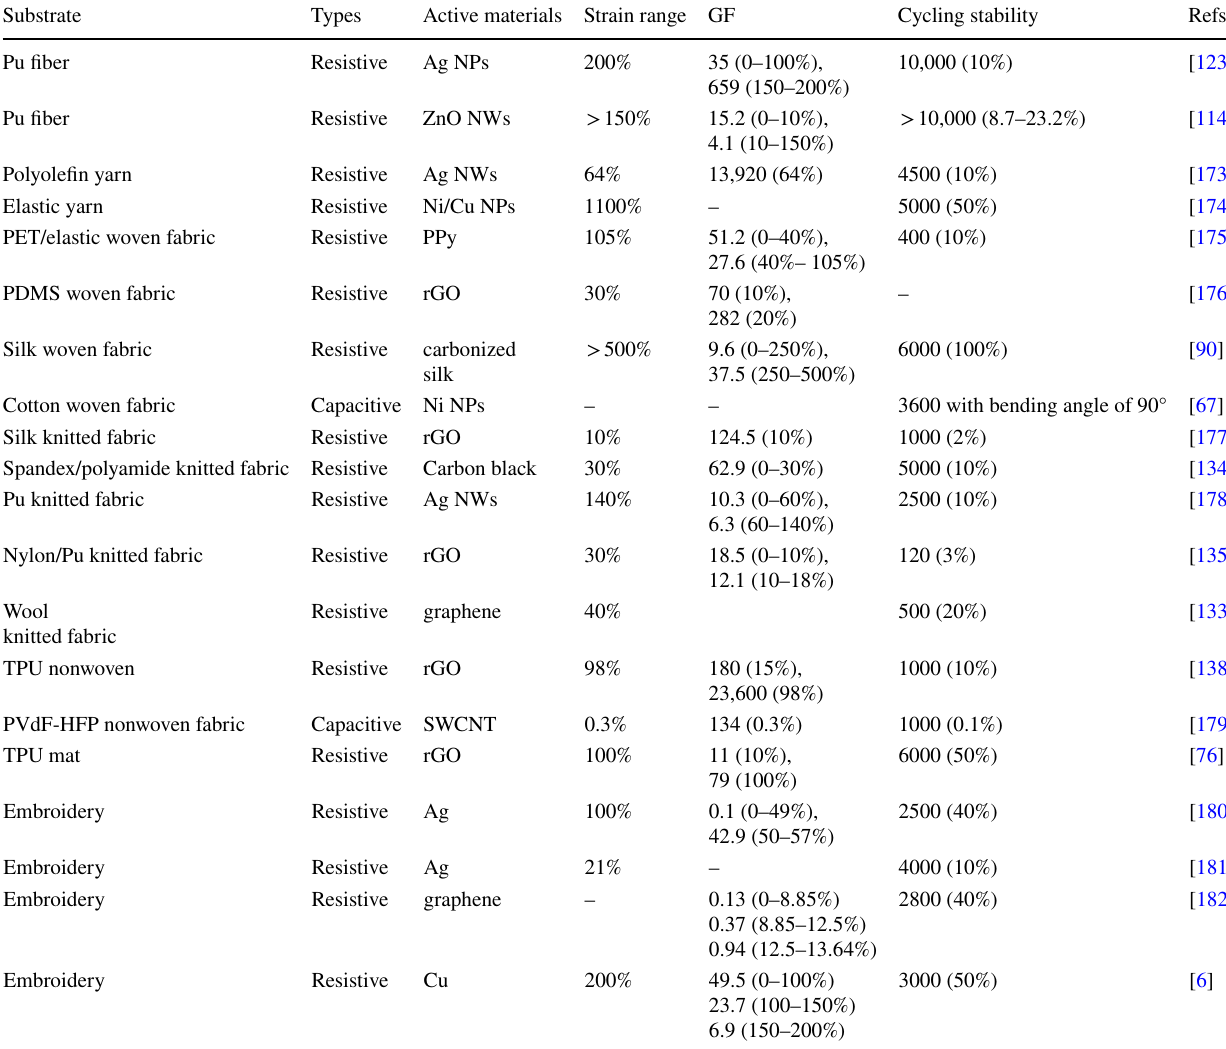
Table 1 Summary of reported fiber-based strain sensors made with textile forming technology Substrate